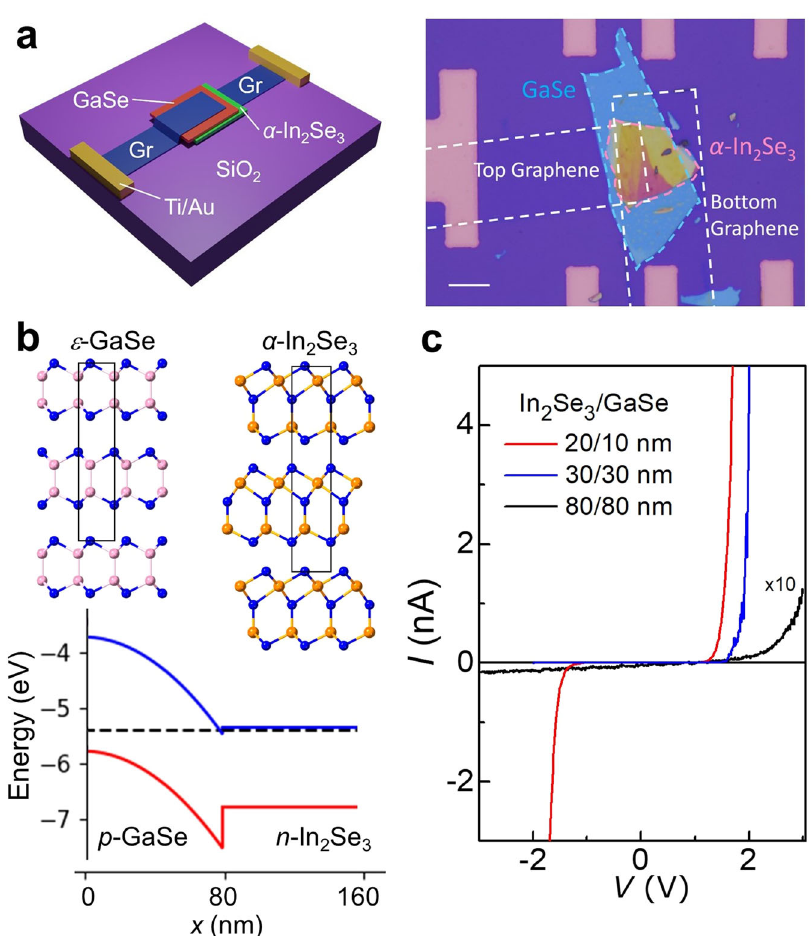
Fig. 1 Graphene-contacted p -GaSe/ n -In 2 Se 3 heterojunctions. a Left: Schematic of a graphene contacted p -GaSe/ n -In 2 Se 3 junction. Right: Optical image of a device with α -In 2 Se 3 and ε -GaSe fl akes with thickness of 20 nm and 10 nm, respectively. Scale bar: 10 μ m. b Top: Crystal structure and unit cell of ε -GaSe and α -In 2 Se 3 . Bottom: Band alignment and Fermi level (dashed line) of a bulk GaSe/In 2 Se 3 junction in equilibrium. c Current – voltage I – V curves in the dark ( T = 300 K) for 3 junctions with different layer thickness of the α -In 2 Se 3 (20, 30, 80 nm) and ε -GaSe (10, 30, 80 nm) fl akes. The optical images for the 30/30 nm and 80/80 nm junctions are in Supplementary Fig. 3a and main text Fig. 4a,